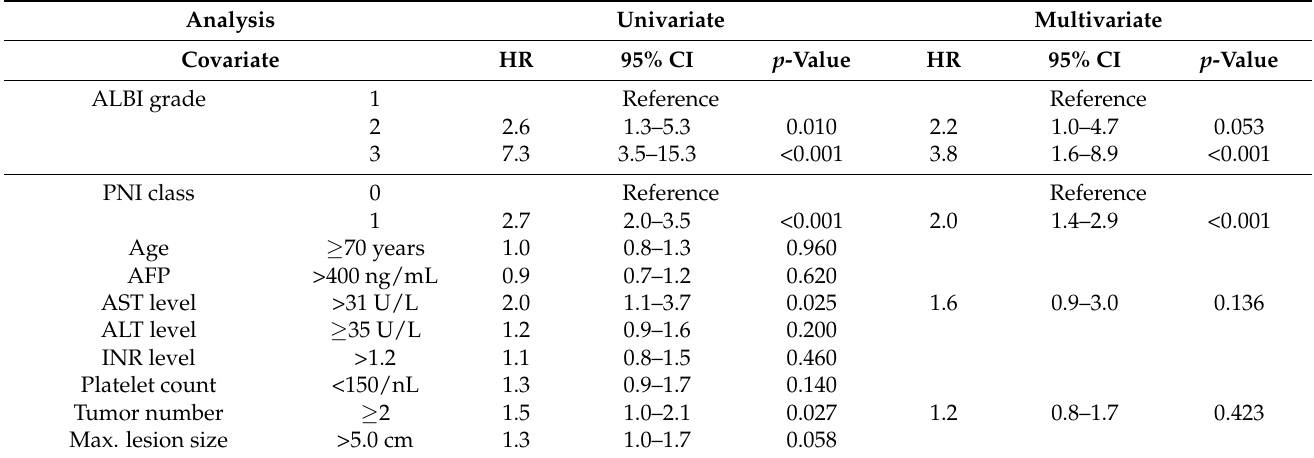
Table 2. Univariate and multivariate Cox proportional hazards regression models evaluating PNI, ALBI grade, and other risk factors.